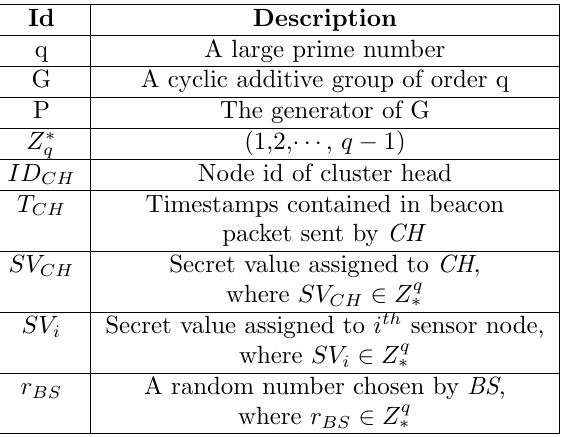
Figure 1. Network architecture of a typical hierarchical WSN Table 1. List of notations used by proposed